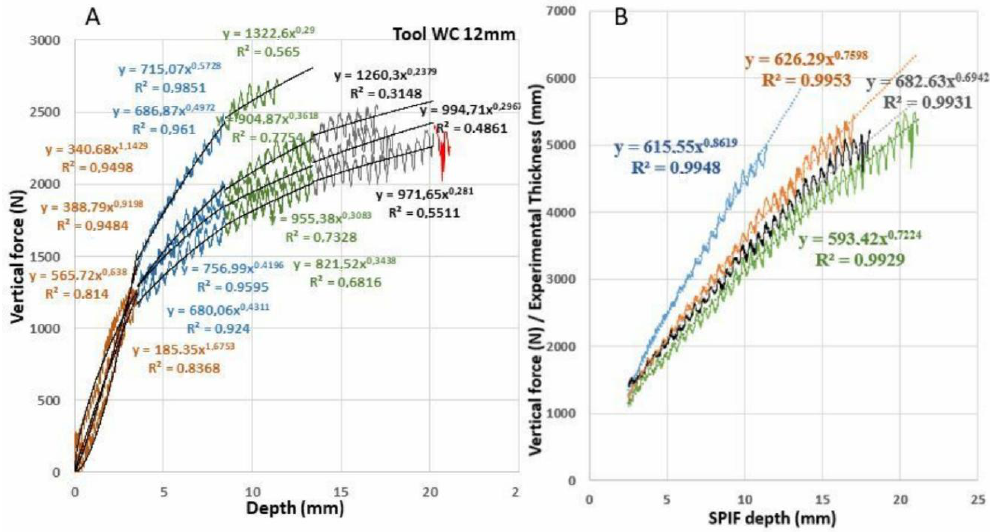
Figure 14. ( A ) Influence of temperature on the vertical force necessary for the process. ( B ) Forces per unit of